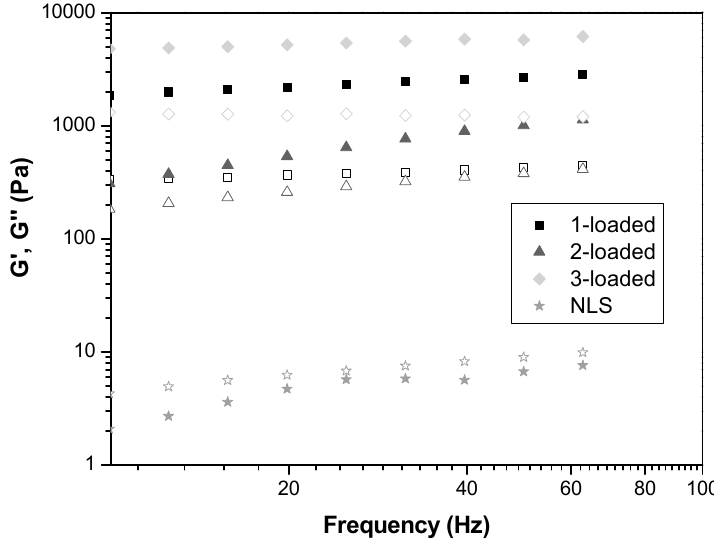
Figure 2. Frequency sweep profiles of NLS, 1-, 2-, and 3-loaded into the NLS at 37 ± 0.5 °C. The storage modulus G ′ is the closed symbols. The loss modulus G ′′ is the opened symbols. The SDs have been omitted for clarity, but the coefficients of variation of the triplicate analyses were less than 10%.